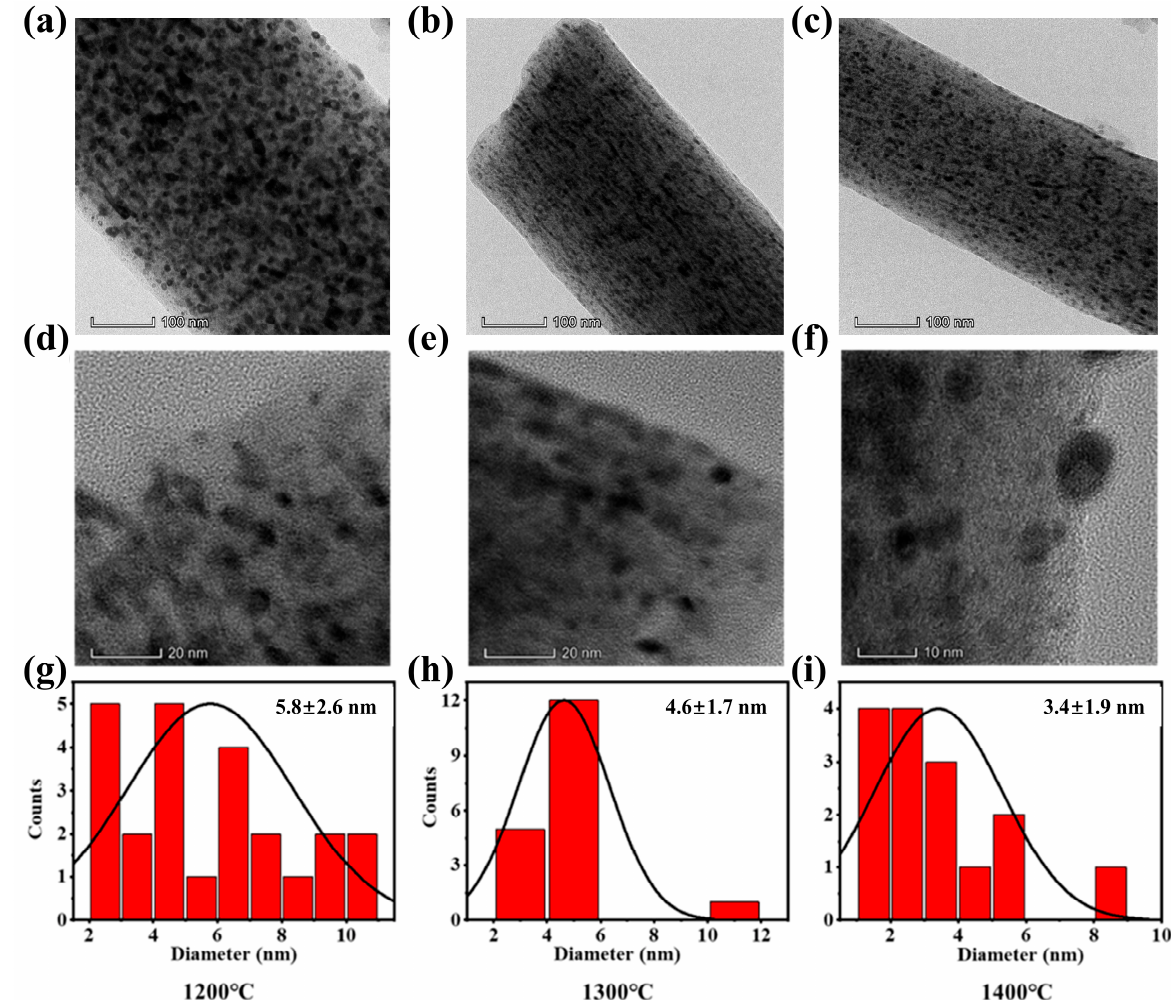
Figure 3. TEM images and grain size distributions of samples at different carbonization temperatures: ( a , d , g ) S-1200 ( b , e , h ) S-1300 and ( c , f , i ) S-1400.